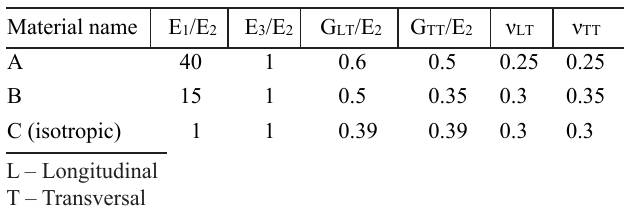
Table 2. Stacking sequence for laminate and sandwich plates (from bottom to